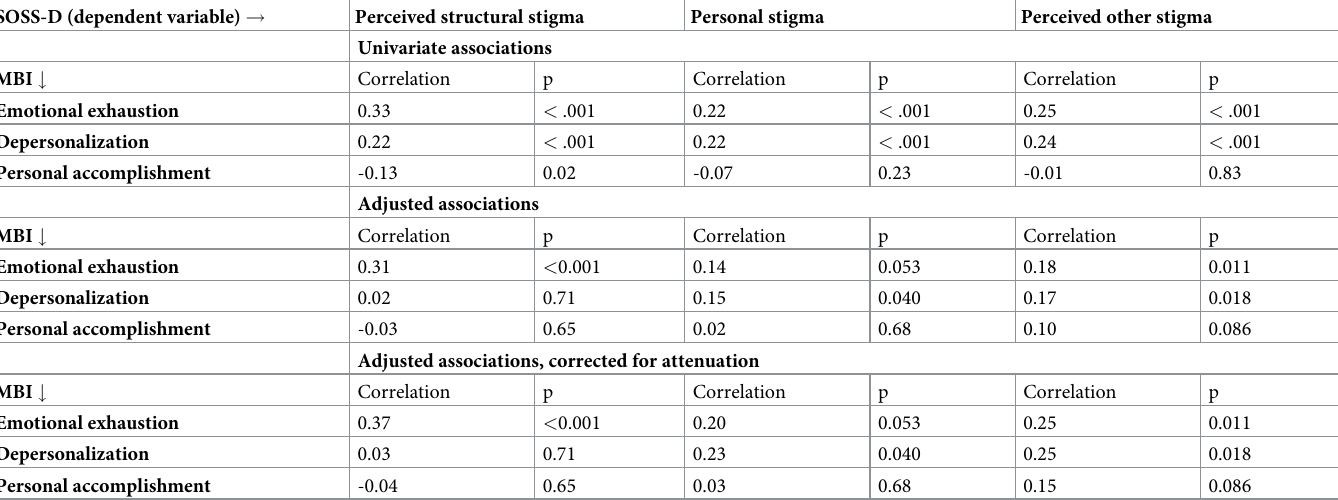
Table 2. Associations between subscales of the MBI and subscales of the SOSS-D, presented as Pearson correlation coefficients. SOSS-D (dependent variable)